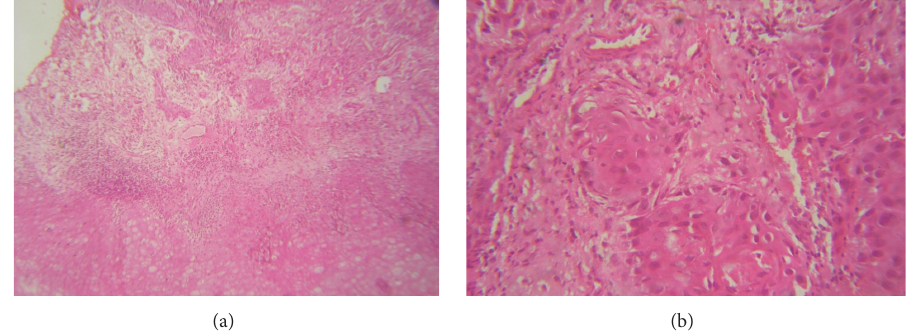
Figure 3: Microscopic image of the lesion exhibiting islands of tumor calls invading the underlying connective tissue stroma (H & E stain at 10x magnification; (a)) with features of nuclear and cytoplasmic atypia (H & E stain at 40x magnification;